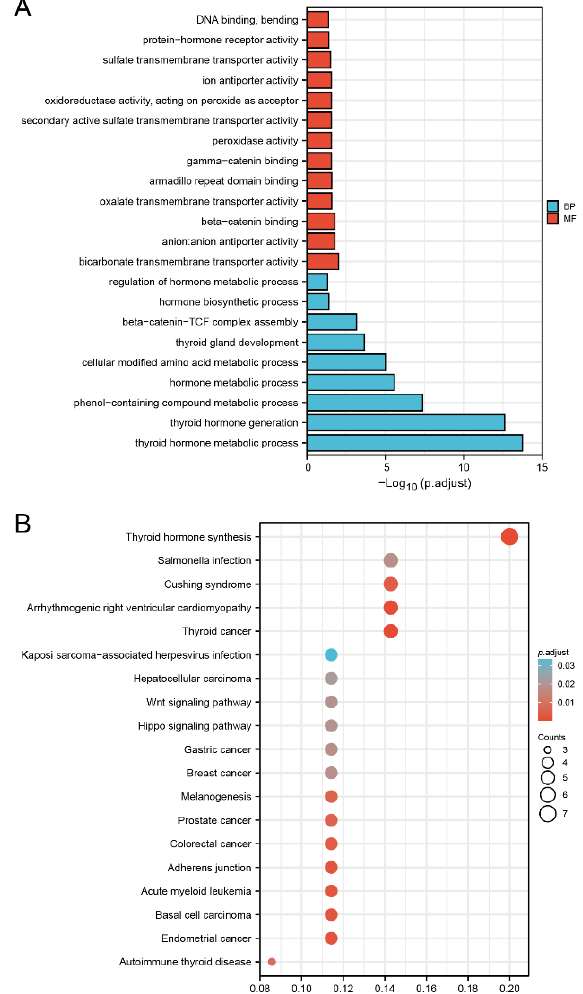
Figure 9. Gene ontology (GO) and Kyoto Encyclopedia of Genes and Genomes (KEGG) analysis of the top 100 genes co-expressed with DMRT3, obtained by GEPIA2. ( A ) GO analysis of the DMRT3 co-expressed genes. ( B ) KEGG analysis of the DMRT3 co-expressed genes.